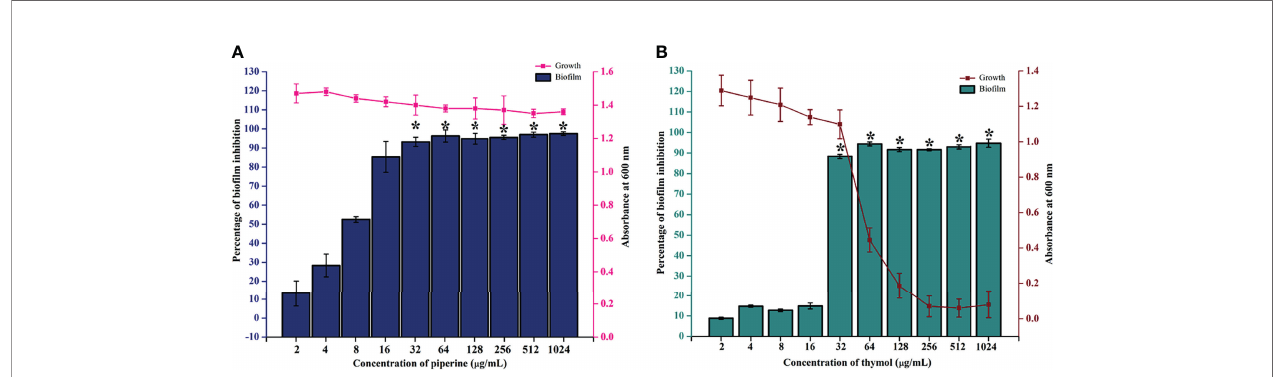
FIGURE 1 | Determination of MBIC of piperine and thymol against C. albicans. (A) Piperine and (B) thymol at the 32-µg/ml concentration signi fi cantly reduced the bio fi lm formation without affecting the growth. Error bars represent standard deviations from the mean, and * indicates signi fi cance p < 0.05.